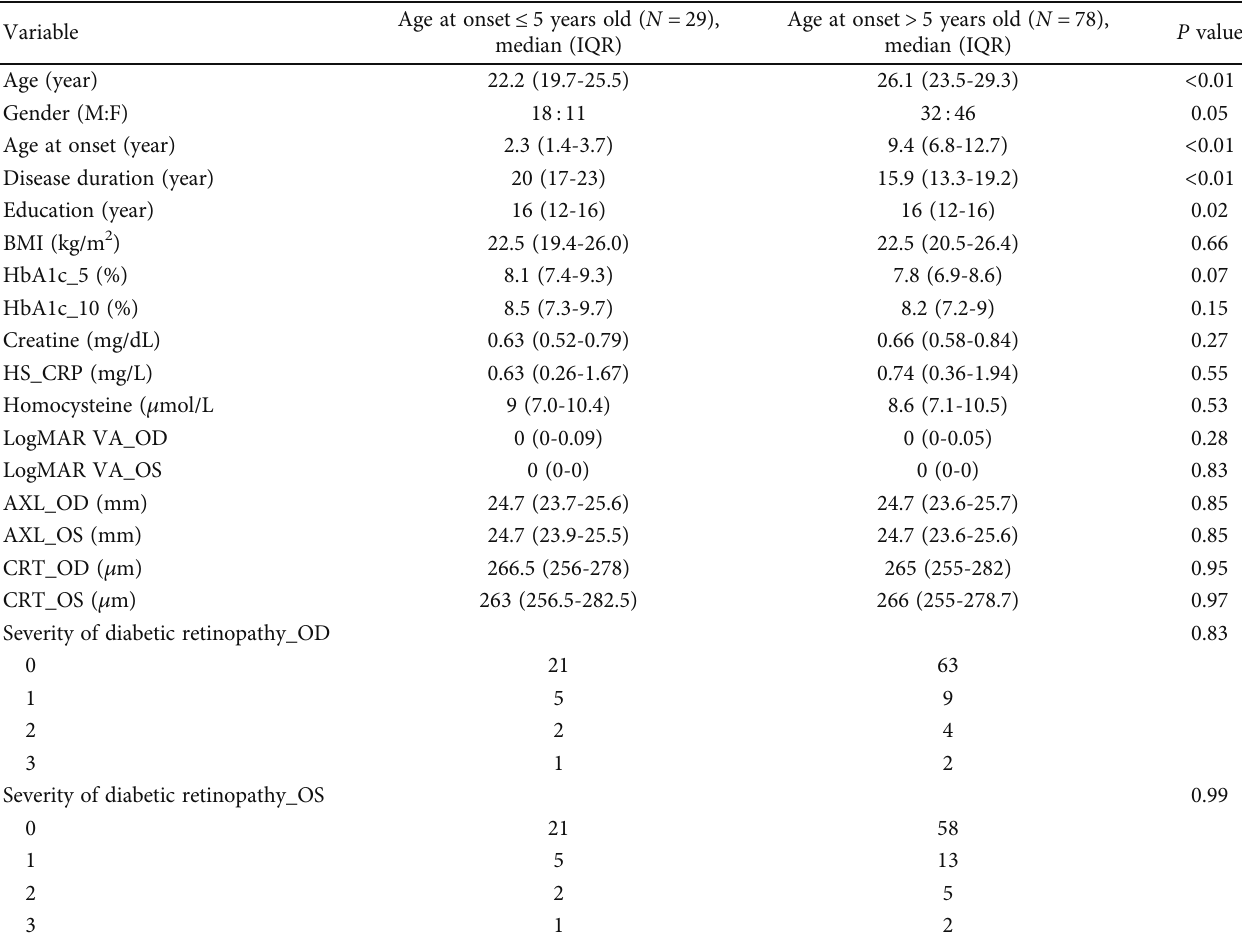
Table 1: Demographic, clinical, and ophthalmic variables between di ff erent groups of age at onset in patients with T1D in this study. Variable